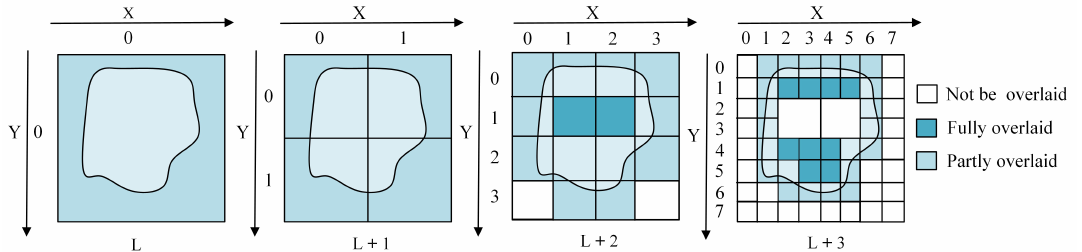
Figure 4. Instance of multi-level grid vector object segmentation.